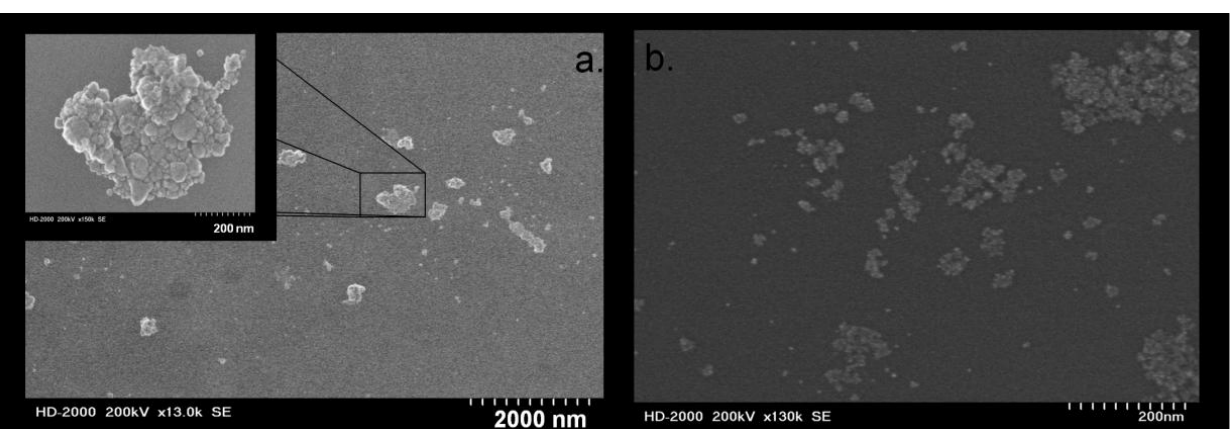
Figure 6. (a) STEM image of polymer nanocomposite synthesis in water. Inset: agglomerate greater than 200 nm; (b) STEM image of polymer nanocomposite synthesis in